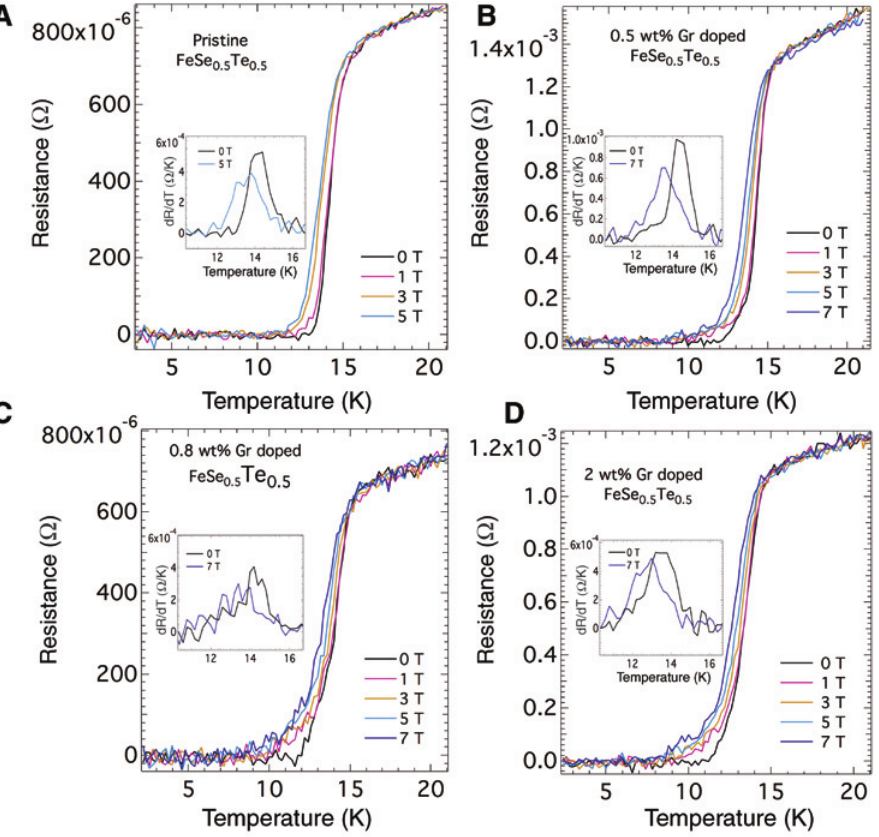
Te samples with (A) 0% wt., (B) 0.5% wt., (C) 0.8% wt. and 0.5 0.5 . For all pristine and doped c